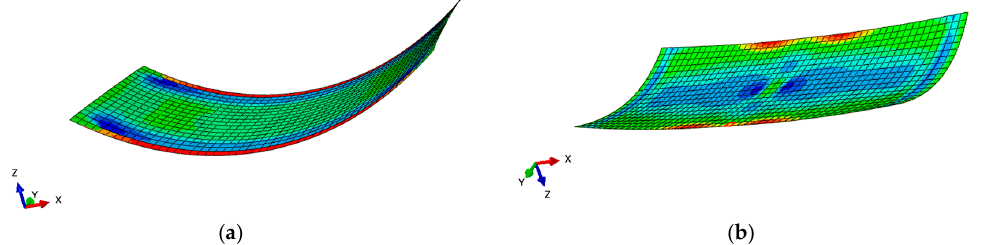
Figure 3. The stable configuration of the bistable composite laminate: ( a ) stable state A; ( b ) stable state